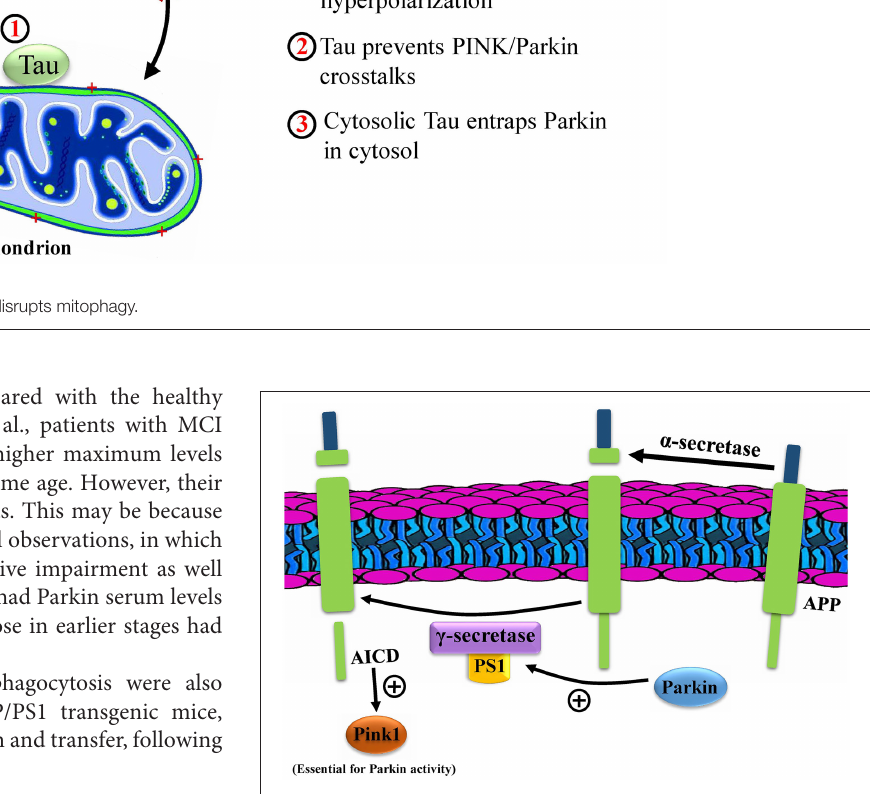
FIGURE 3 | Parkin enhances PINK1 through presenillins (PS). AICD, APP intracellular domain; APP, amyloid precursor